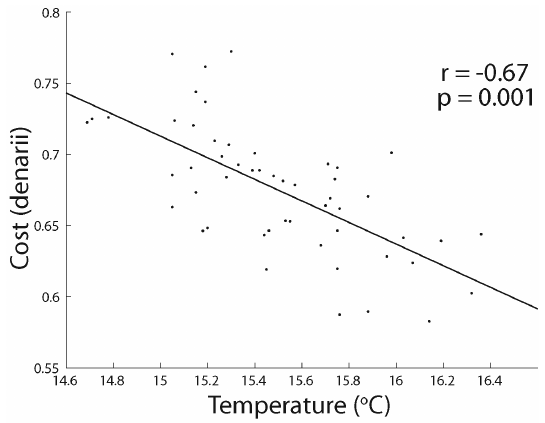
Figure 6. Cost of imports in relation to temperature. There is a neg- ative relation between the cost to import VW and temperature be- cause yields increase on average in the Mediterranean with increas- ing temperature. Therefore competition for VW resources reduces and as a result, import distances